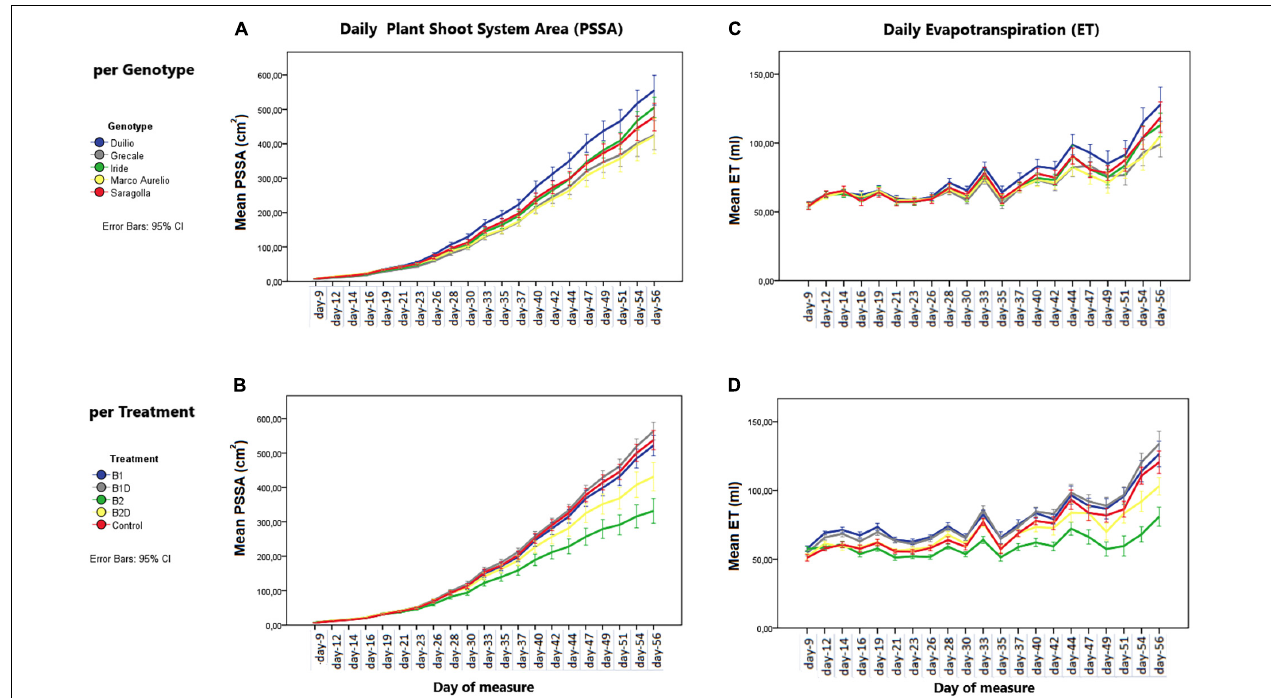
FIGURE 2 | (A,B) Plant shoot system area (PSSA) per day (in cm 2 ) on the left and (C,D) evapotranspiration (ET) by the “pot + plant” system per day (in ml) on the right. The dynamic trends are displayed by these two parameters, per day of measure, in the (A,C) different genotypes and (B,D) different treatments. Bars represent mean values, with error bars denoting 95% confidence interval